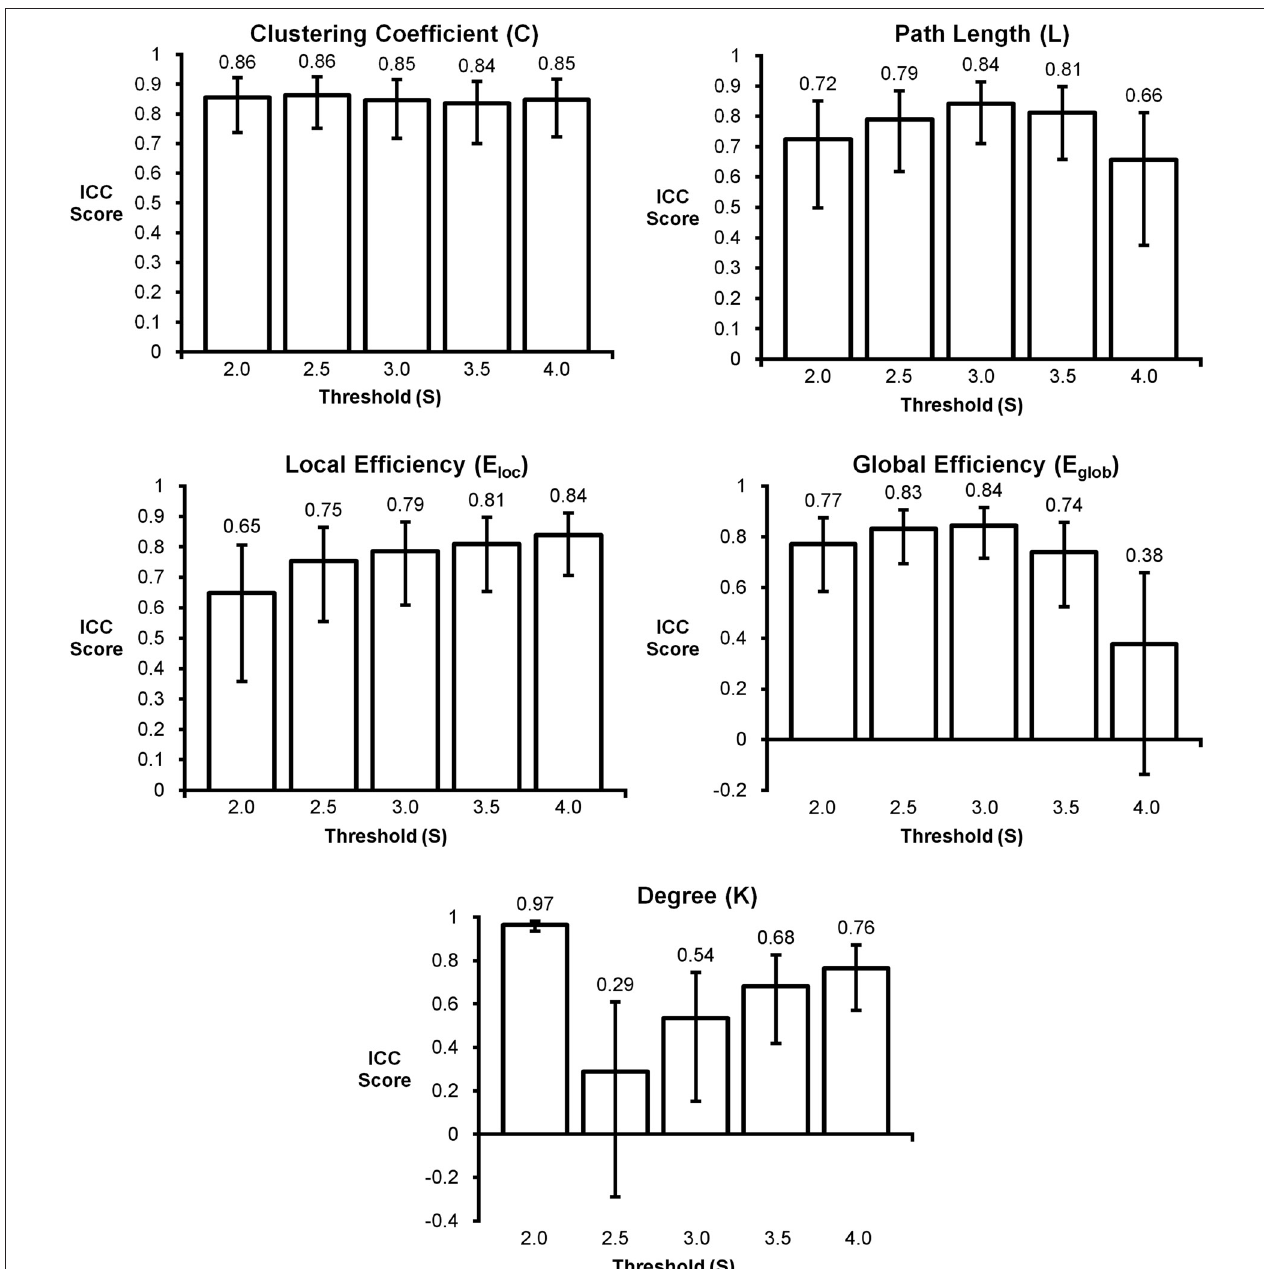
FIguRe 4 | Intraclass correlation coefficient plots for graph metrics across different thresholds. Clustering coefficient had the most consistent reproducibility across thresholds, while degree appears to change the most as the threshold changes. Reproducibility across thresholds S = 2.5–3.5 appears to be consistent for most graph